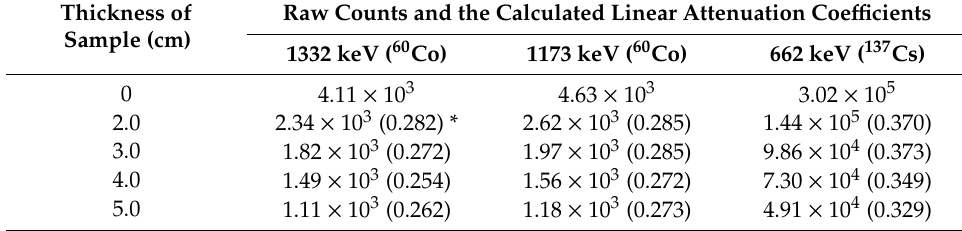
Table 3. Peak energy counts and the calculated linear attenuation coefficients of the Iron (III) oxide- based ceramic.